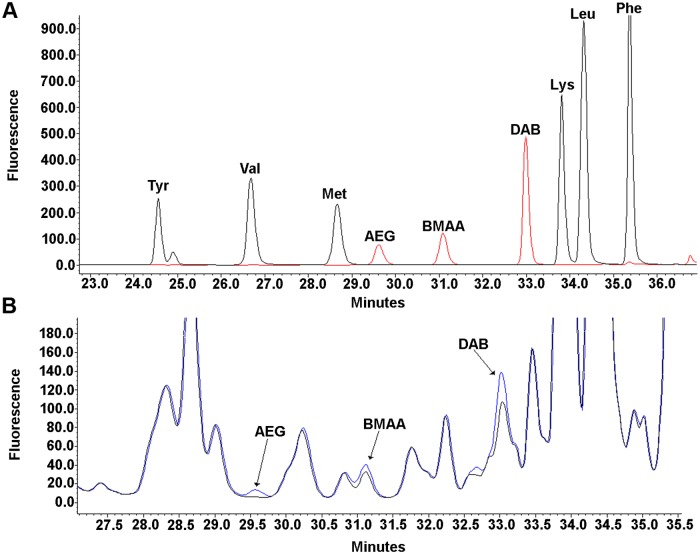
HPLC-FD detection of BMAA in the cerebral cortex of stranded dolphins.(A) Separation of 6-aminoquinolyl-N-hydroxysuccinimidyl carbamate (AQC) derivatized amino acid standards tyrosine (Try), valine (Val), methionine (Met), Lysine (Lys), Leucine (Leu) and Phenylalanine (Phe). BMAA and BMAA structural isomers N-(2-aminoethyl)-glycine (AEG) & 2,4-diaminobutyric acid (DAB) standards are shown in red. (B) Representative chromatogram from the visual cortex (VCtx) of stranded dolphin IFAW12-201Dd with low-concentration spikes of BMAA and BMAA isomer standards in the same dolphin sample shown in blue. Chromatogram shows BMAA has a distinct peak with a retention time of 31.1 minutes. AEG and DAB have distinct retention times of 29.6 and 33.0 minutes, respectively.